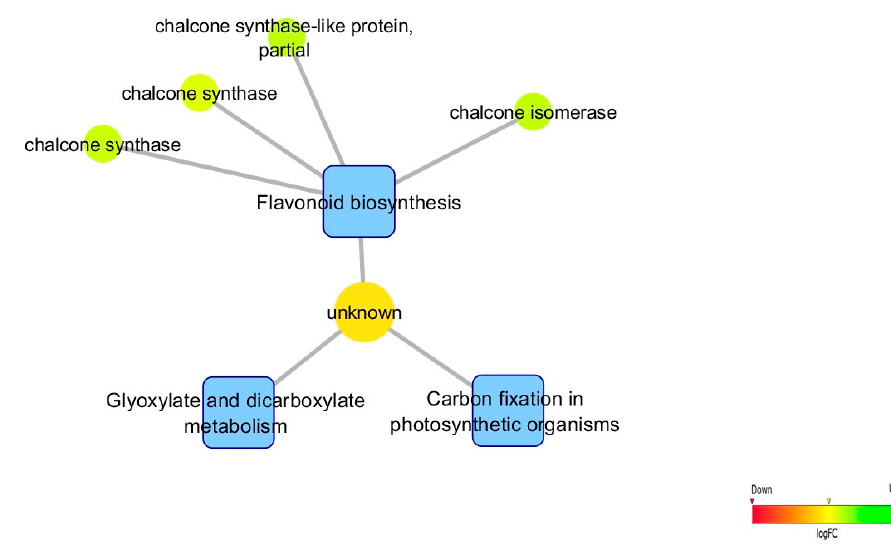
Figure 5. Flavonoid biosynthesis pathway with interactions related to DE genes in the comparison: Pp01–Pp02. The blue square nodes represent the pathways. The rest of the nodes represent all DE genes associated to the pathways. Note that due to the complexity of representing the expression values of those genes, the RGB color scale goes from the most down regulated in red to the most up regulated in green.